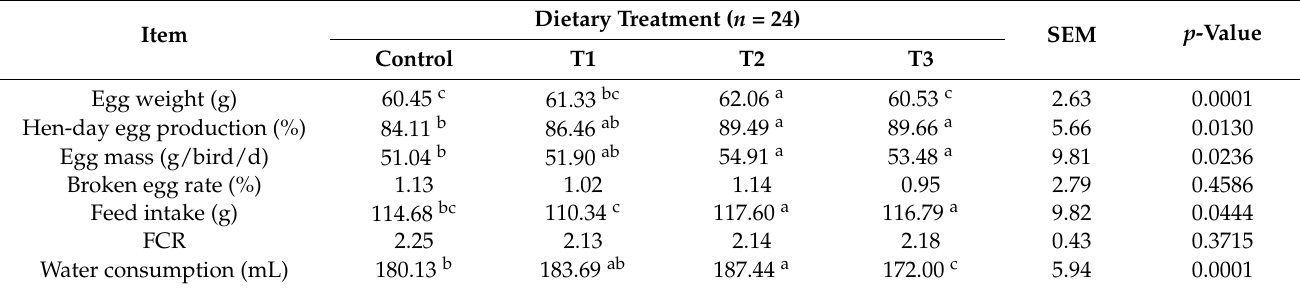
Table 2. Effects of Mentha arvensis (MA) and Geranium thunbergii (GT) on egg performance of laying hens.